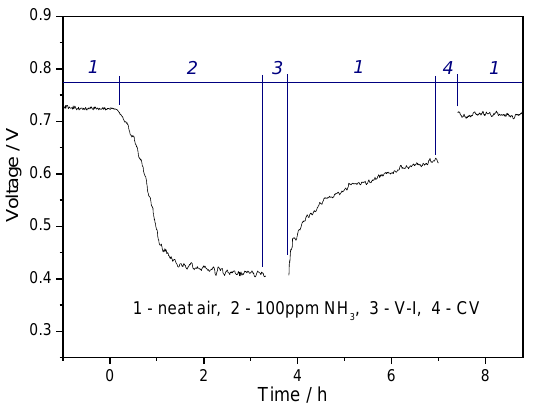
Figure 3. Recovery of cell voltage with discharging with neat air, V-I test, and CV at 500 mA/cm 2 .